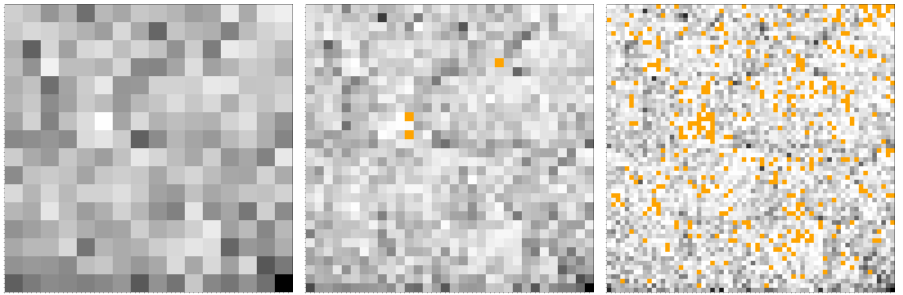
Figure 6. FCGR of E. coli at various iterations k . ( Left ) k = 4. ( Middle ) k = 5. ( Right ) k = 6. Orange points indicate missing nucleotide